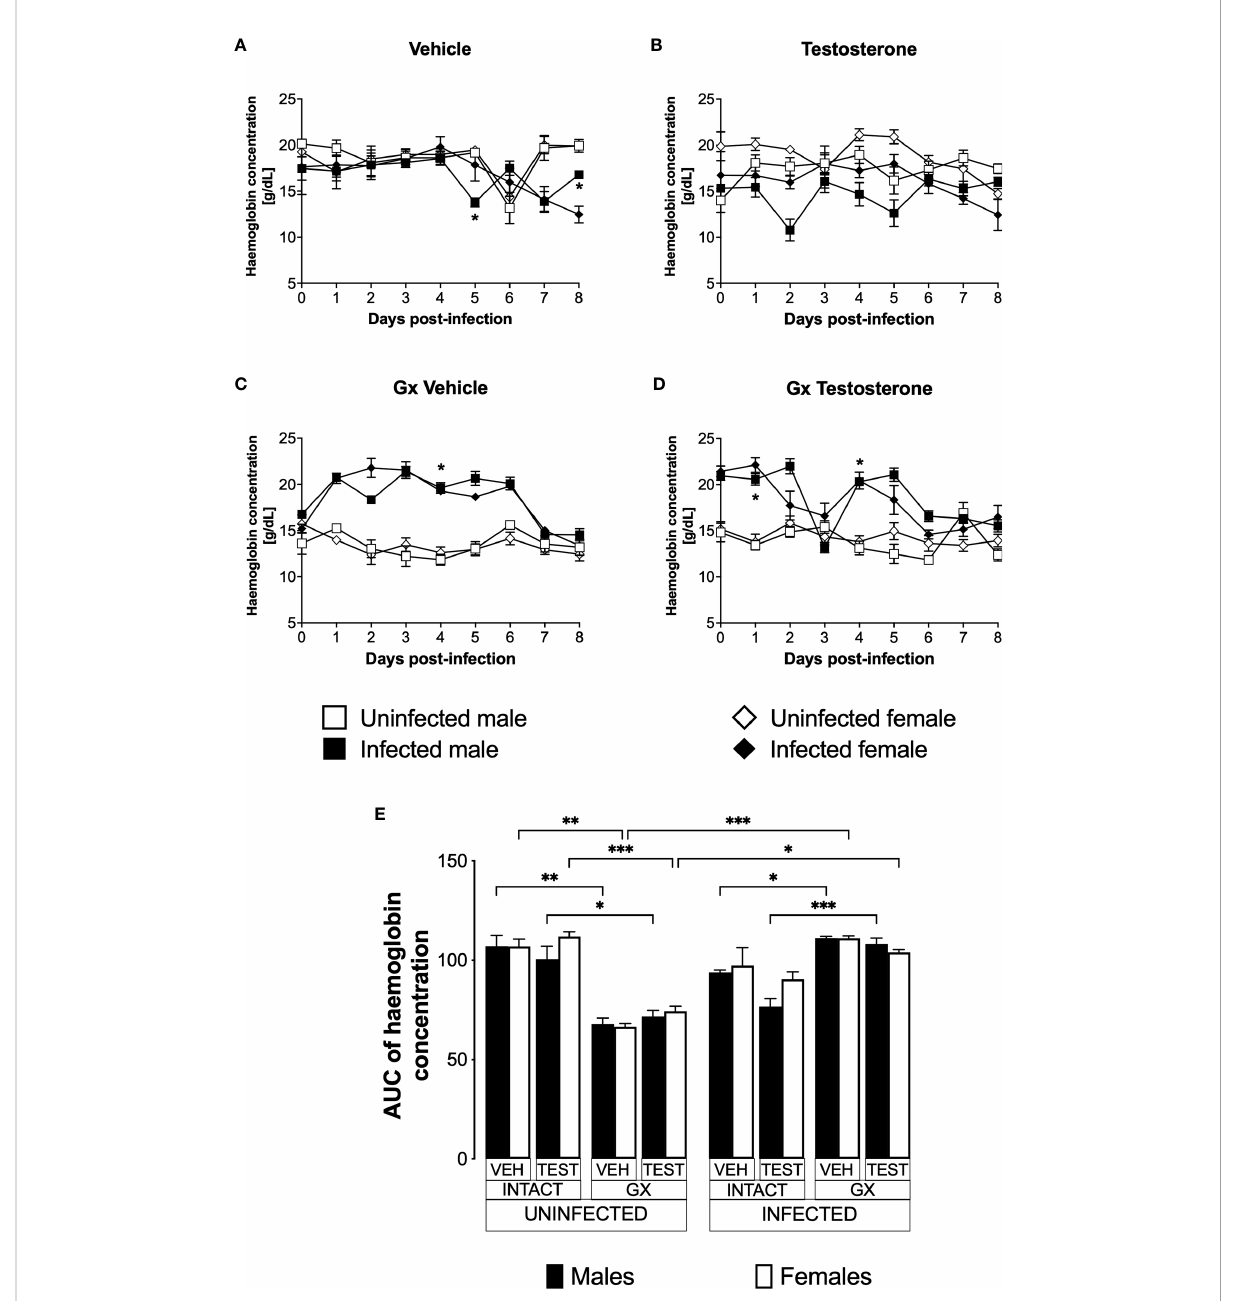
FIGURE 3 Gonadectomy prevented haemoglobin level reduction in mice infected with P. berghei ANKA. We used 8 groups of males and 8 groups of females, 4 groups of each sex were gonadectomised (GX), and the other 4 groups were left intact; four weeks after surgery, two groups of intact and two GX mice of each sex were administered testosterone for 3 weeks, the other two received vehicle for the same time. Finally, one intact and one GX group treated with testosterone of each sex were infected with P. berghei ANKA. The remaining groups were injected with PBS as negative infection controls. From the day of infection, haemoglobin concentration was quanti fi ed in all groups. (A) shows haemoglobin concentration in vehicle-treated male and female intact mice infected or uninfected with the parasite; (B) shows haemoglobin concentration in testosterone-treated male and female intact mice groups; (C) shows haemoglobin concentration in vehicle-treated GX groups infected or uninfected in both sexes; (D) shows haemoglobin concentration in the testosterone-treated GX groups infected or uninfected. Asterisks represent statistically signi fi cant differences between uninfected and infected groups, obtained by repeated means ANOVA with a Bonferroni post-hoc test (*) p ≤ 0.05. Finally, (E) shows the area under the curve analysis (AUC) of the vehicle-treated (VEH), testosterone-treated (TEST), intact (INTACT), or gonadectomised (GX) groups. Mice infected with P. berghei ANKA (INFECTED) or uninfected (UNINFECTED). Each bar represents the mean ± SEM. Asterisks denote statistical signi fi cance between 2 groups (*) p<0.05; (**) p<0.01; (***) p<0.001; calculated by Kruskal-Wallis analysis with Dunn ’ s post-hoc test. The whole experiment was performed twice